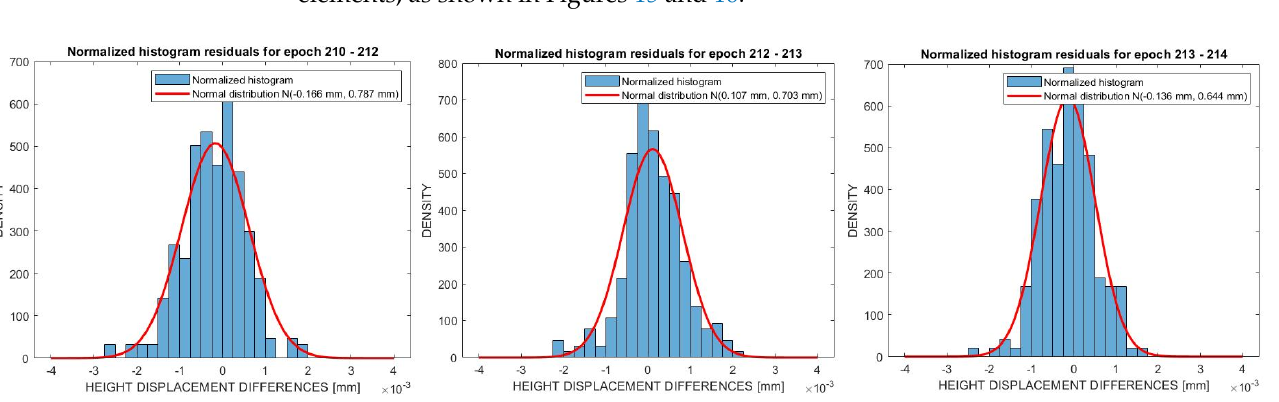
Table 6. Statistical parameters for residuals for BEAM 2.